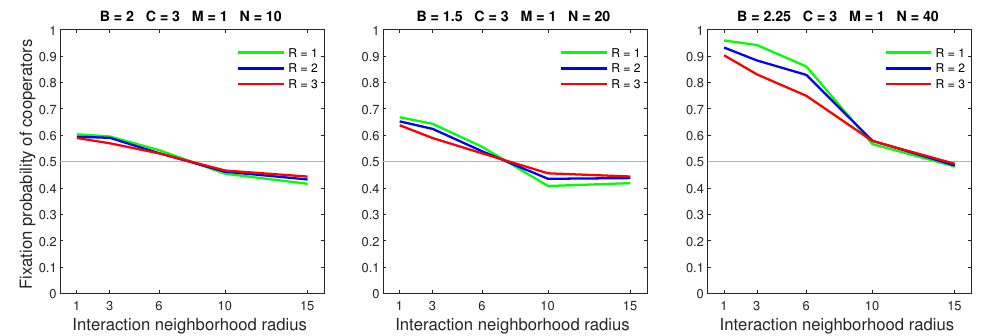
Figure 14. In the deterministic dispersal model, increasing the dispersal range for a low mobility rate ( M = 1) causes small declines in the fixation probability of dense populations while leaving sparse populations unaltered.